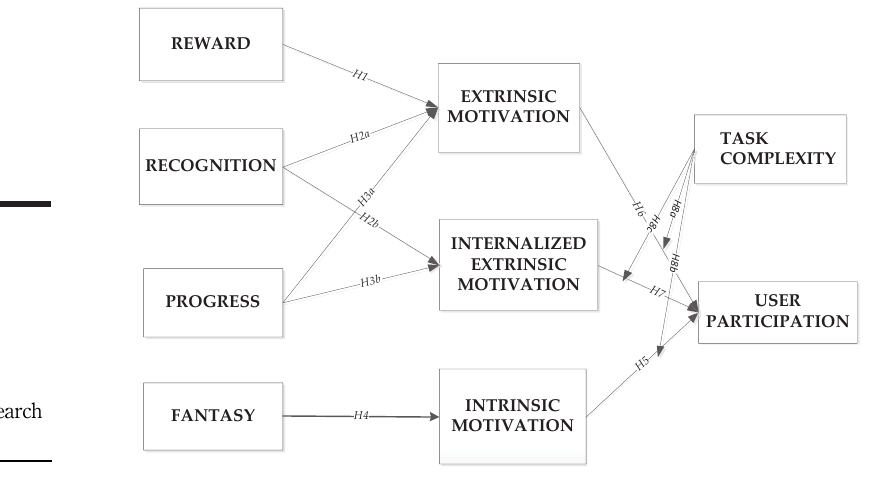
Figure 1. A proposal research